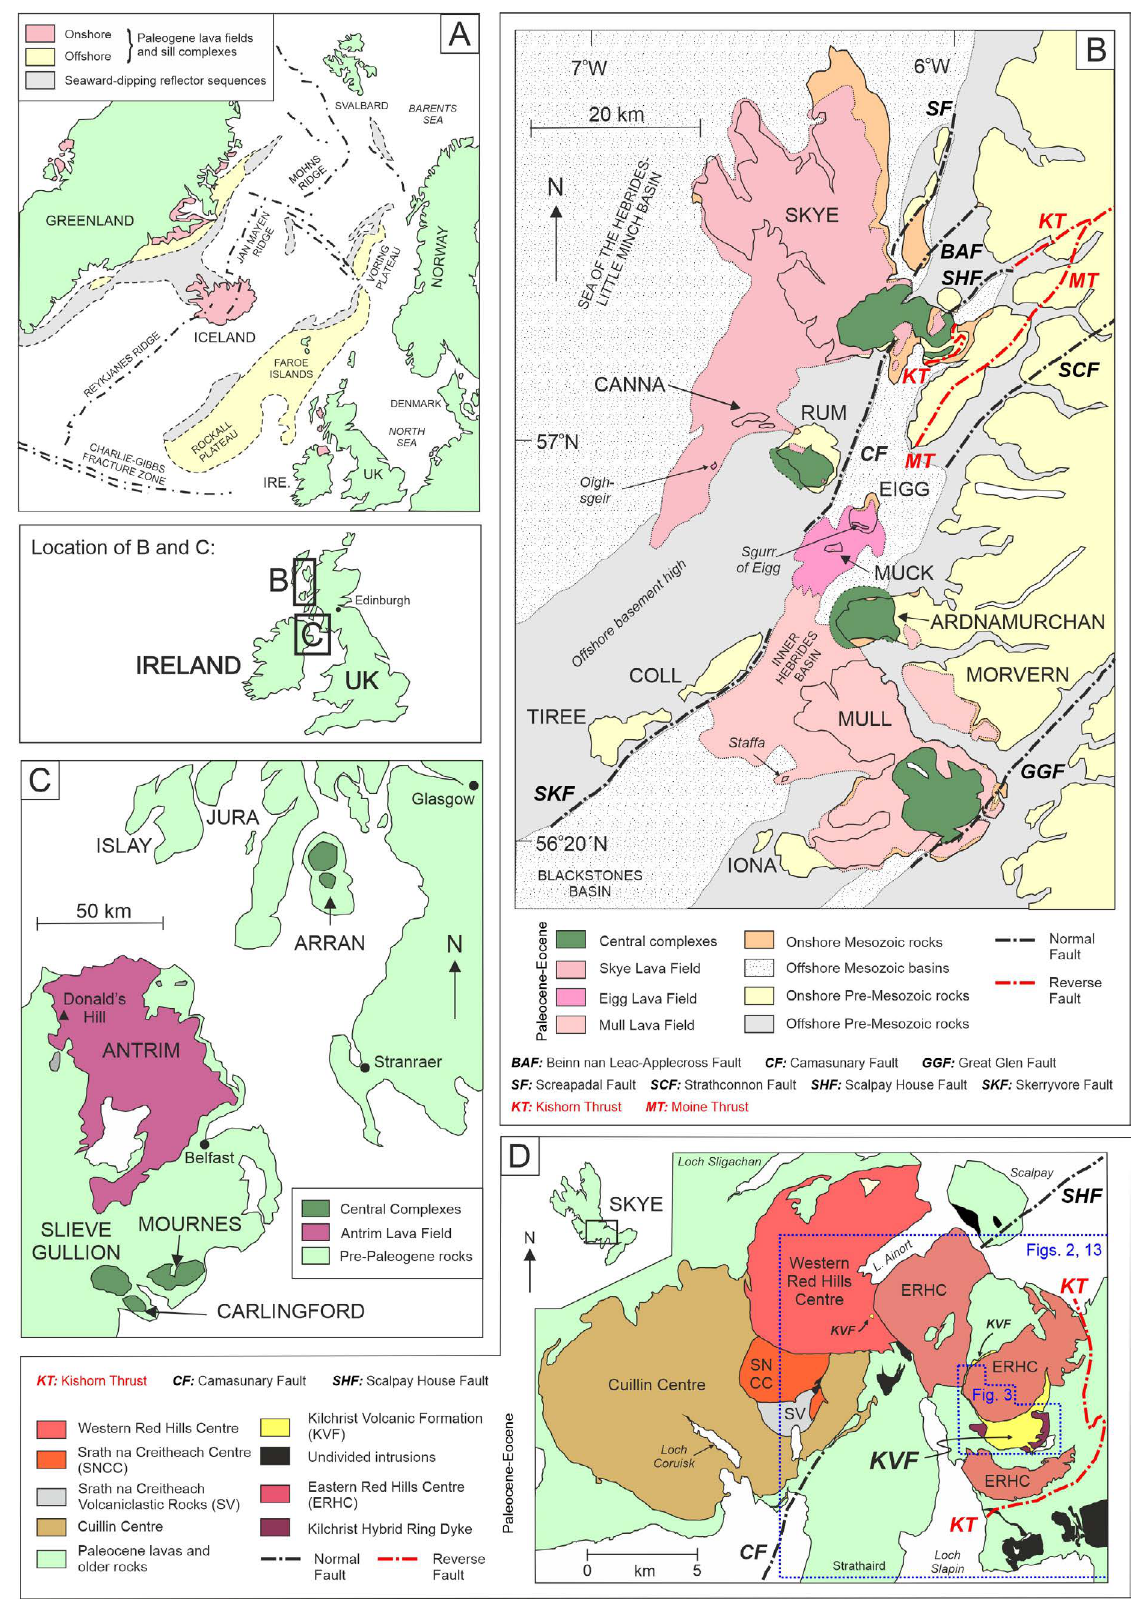
Figure 1: [A] The North Atlantic Igneous Province with [B] and [C] insets showing the British Paleogene Igneous Province (BPIP). [B] The BPIP and relative positions of its lava fields and central complexes (modified from Emeleus and Bell [2005]). Major pre-Paleocene faults are shown in red and black hatched lines. [D] Map of Skye Central Complex showing position of Kilchrist Volcanic Formation (KVF) in relation to gabbroic and granitic intrusions. Locations of Figure 2 and Figure 13